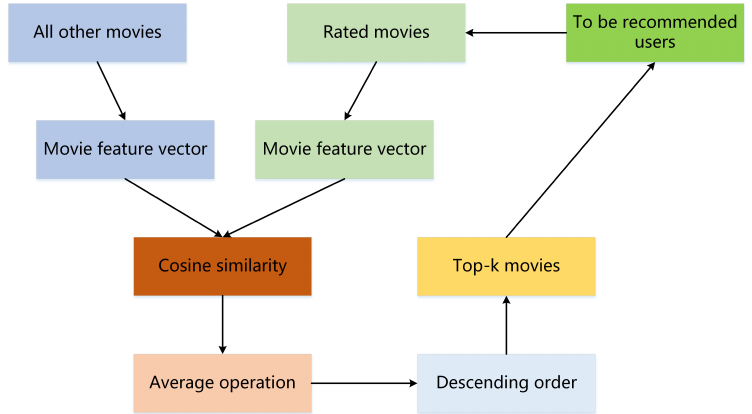
Figure 12. Scheme 3 recommended strategy